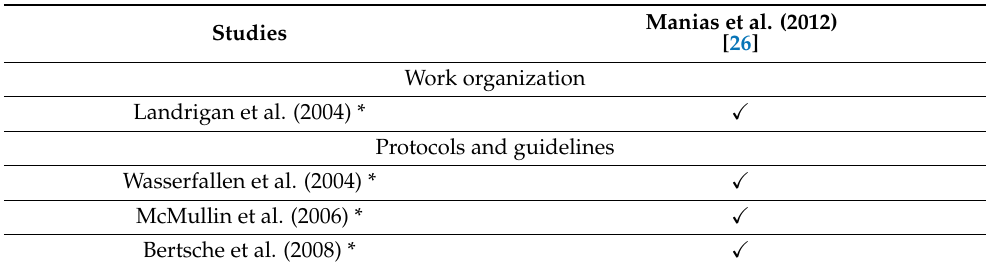
Table 6. Studies on organizational interventions to prevent medication errors included in the analyzed systematic